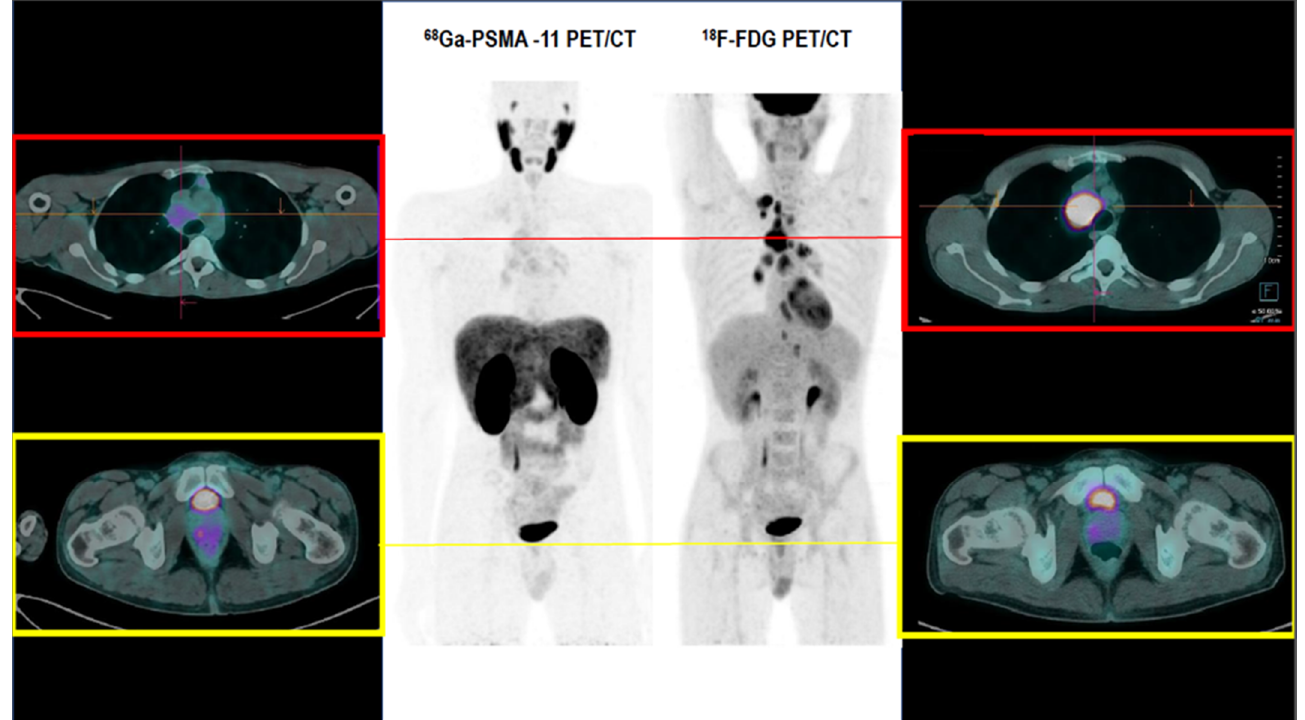
Figure 1. The central panel displays the Maximum Intensity Projection (MIP) of 68Ga-PSMA-11 and 18F-FDG PET/CT scans. The left axial hybrid PET/CT images show the focal 68Ga-PSMA uptake at the peripheral zone of the right prostatic lobe ( yellow ) and the mild tracer uptake by enlarged mediastinal lymph nodes ( red ). The right axial hybrid PET/CT images show the high 18F-FDG uptake by the enlarged mediastinal lymphatic stations ( red ) and the low 18F-FDG uptake by the peripheral zone of the right prostatic lobe ( yellow ).